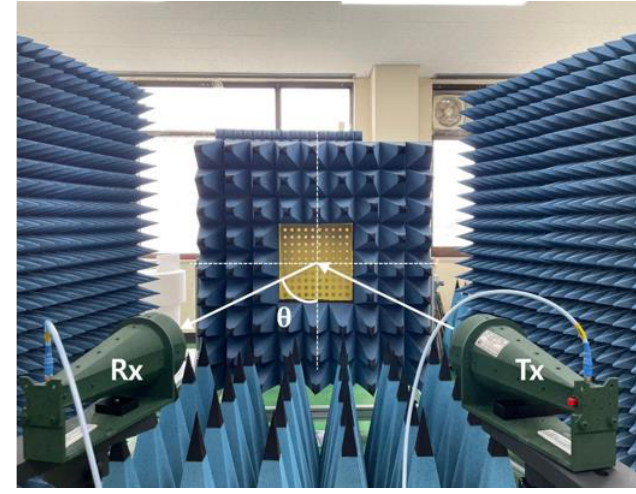
Figure 11. Measurement setup to measure different parameters.